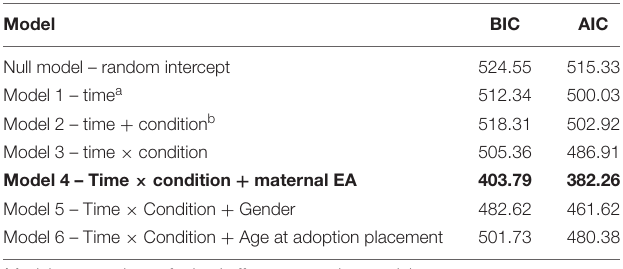
TABLE 3 | VIPP-FC/A intervention effects on children.